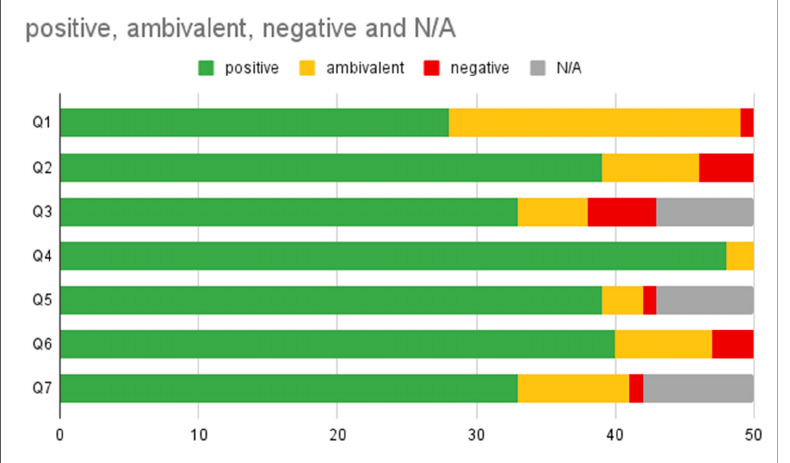
Figure 11. Showing summary results of exit survey Q1–7. (see Table 3 for exit survey questions) Data ranks (Q1, 2, 4, 6) were scored as 4–5 = positive (green), 3 = ambivalent (orange), 1–2 = negative (red); open responses (Q3, 5, 7) were coded positive (green) ambivalent (orange) and negative (red). Gray indicates no or inapplicable